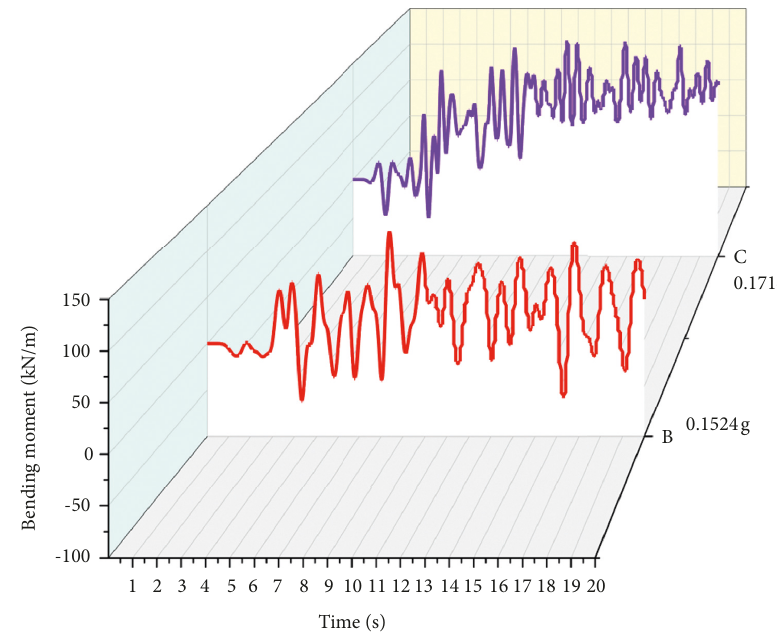
Figure 9: Top of pile bending moment for time-history